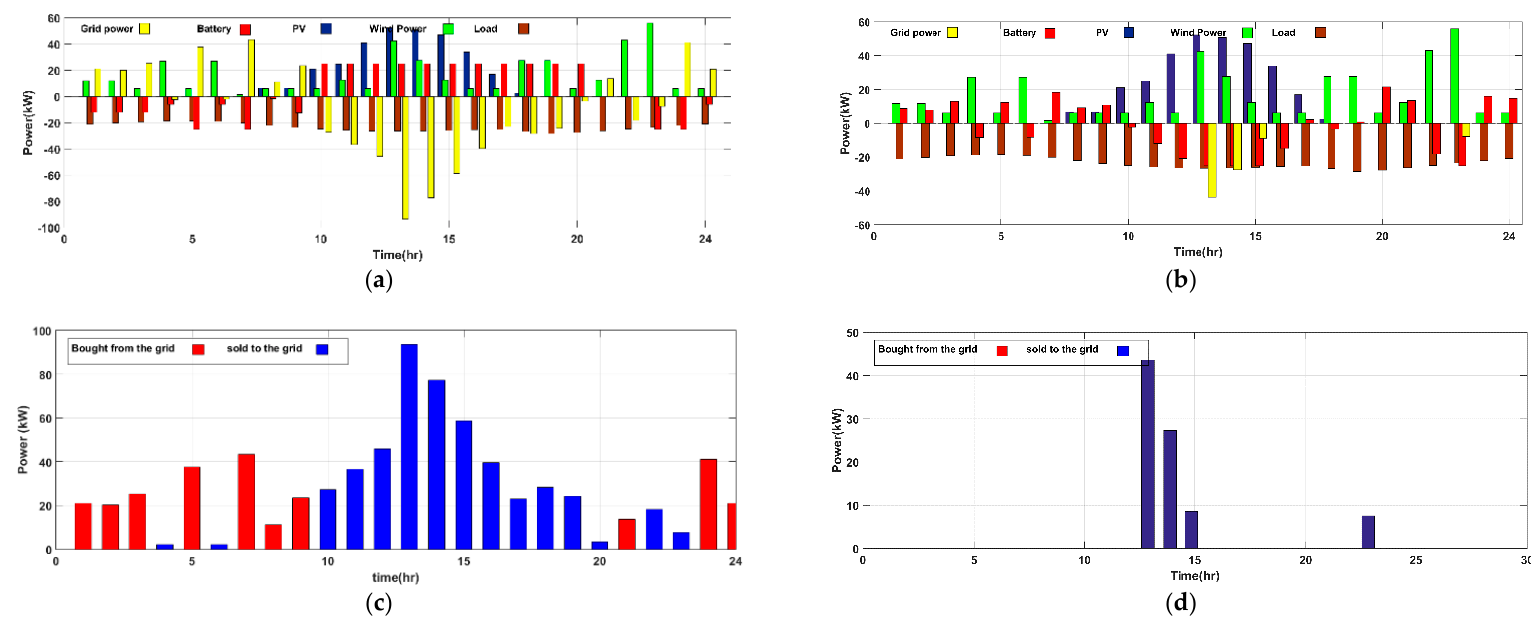
Figure 11. ( a , b ) Microgrid scheduled power flow with and without EMS respectively in case 1. ( c , d ) The purchased/sold power from the grid during the day with and without EMS. Table 4. Electricity trade results for different case studies with and without EMS.